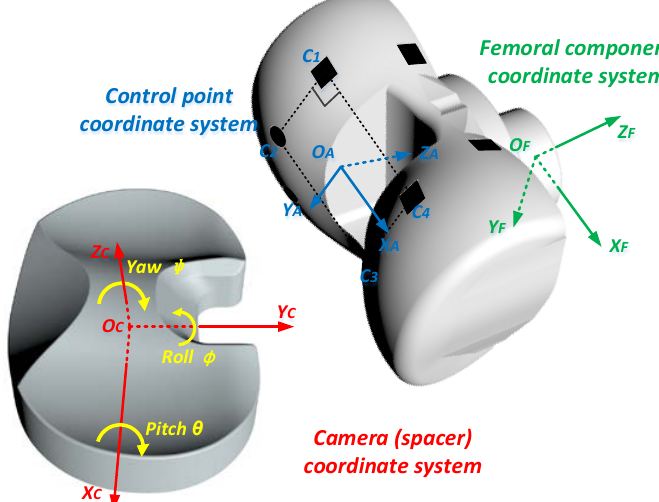
Figure 10. The coordinate systems to represent the relative position between the spacer and the femoral component.